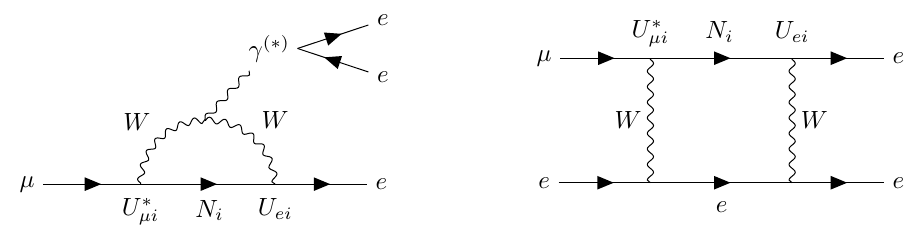
Figure 5 . Diagrams leading to (cid:22)